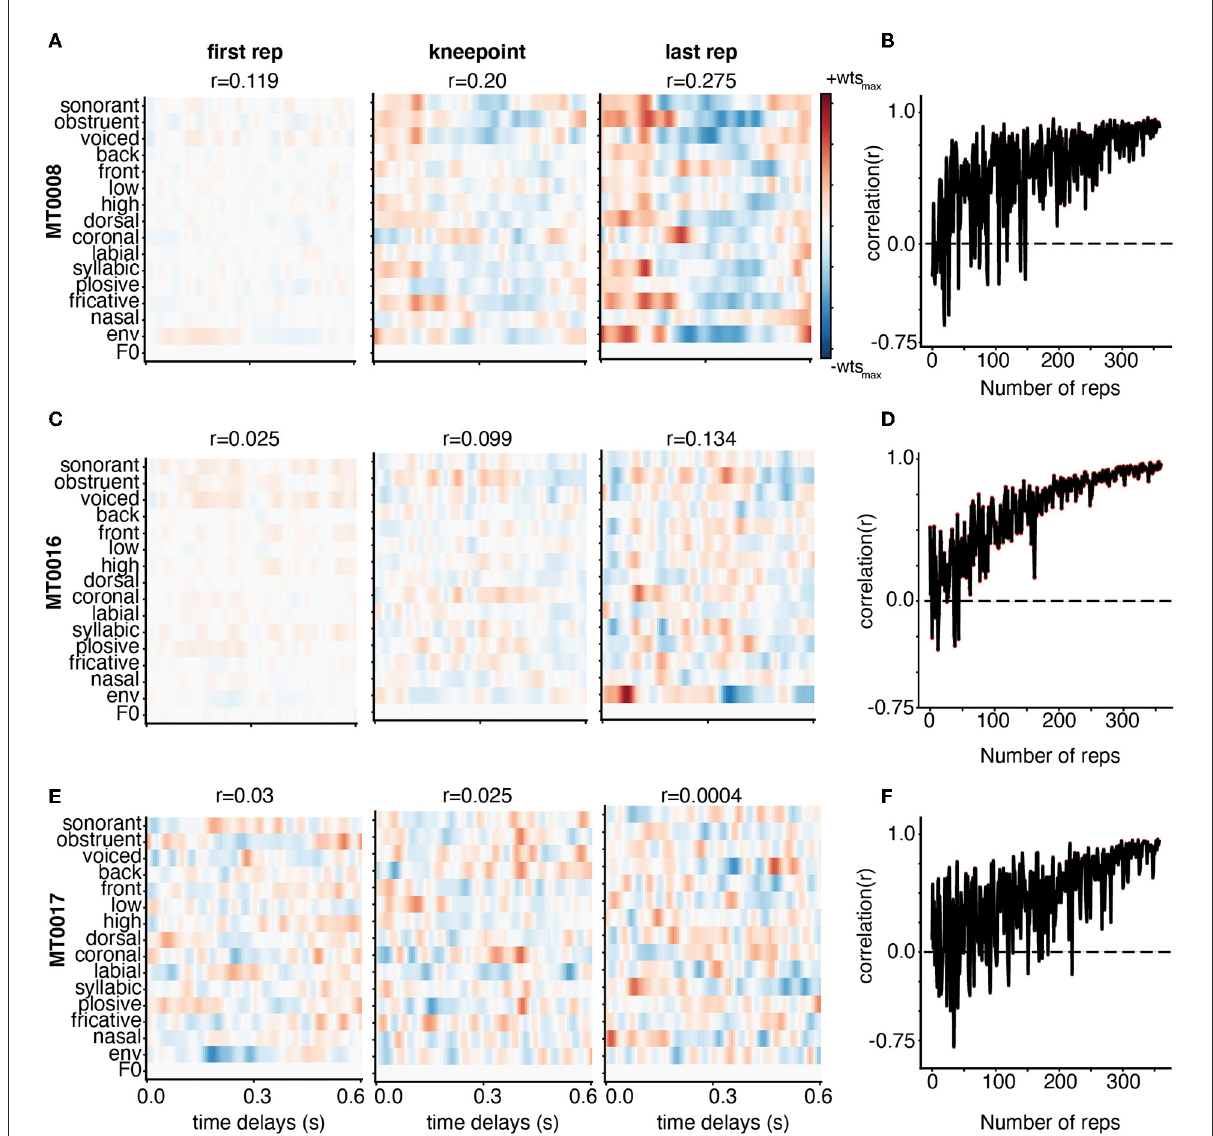
FIGURE3 Weight stabilization for three subjects with varying model performance using TIMIT. Subjects MT0008 (A) , MT0016 (C) , MT0017 (E) are shown as examples of the best, average, and poor encoding models based on the correlation between predicted and actual EEG for held out data. The model performance correlation values are reported above the corresponding receptive field. Weights are shown from the encoding model based on the first repetition (left), knee point value for that participant (middle), and last repetition (right panel). For all subjects, the weights are plotted for all auditory features across time delays: 0–0.6s. In the best and average participant, the model weights between the knee point and the last repetition appear similar with clear structure. On the other hand, the poorly fit participant (MT0017) has no discernable structure in the receptive field at any repetition. (B, D, F) Adjacent weights for the full auditory model for each subject were correlated with each other and plotted across the number of repetitions. This curve shows a general trend toward stabilization of receptive field structure as repetitions are added to the training